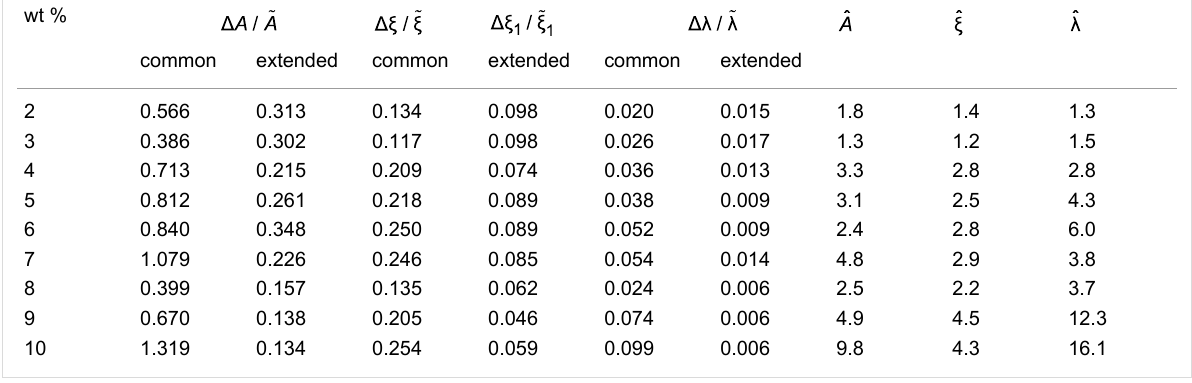
Table 1: Comparison of the relative errors of A , ξ and λ obtained by using the common or the extended fitting equation. In the last column, the rela- tive increase in precision of the extended equation over the common equation is given by dividing the error of the common equation by the error of the extended equation. The quotient ( ) is given for all three parameters.